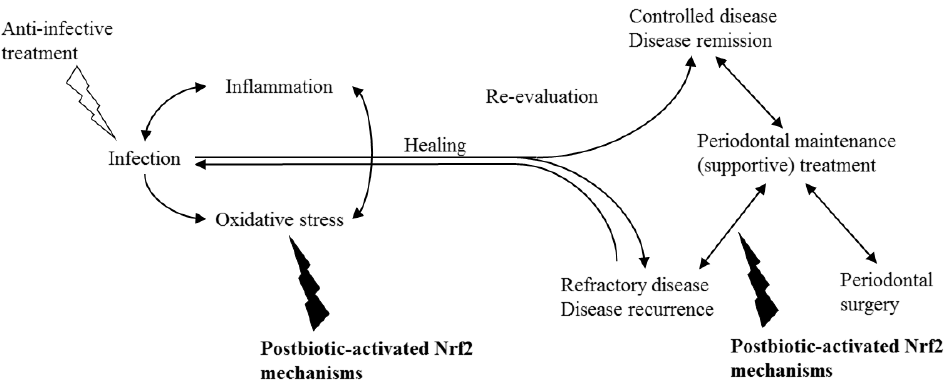
Figure 4. The primary aim of conventional periodontal treatment is to control inflammation and oxidative stress by reducing the infection. Yet, host-modifying agents can be beneficial in unresponsive and/or susceptible individuals. Postbiotic-activated Nrf2 mechanisms can be considered as potential agents to control the inflammation by reducing oxidative stress as an adjunct to anti-infective periodontal treatment or during supportive therapy to prevent recurrence in high-risk individuals.